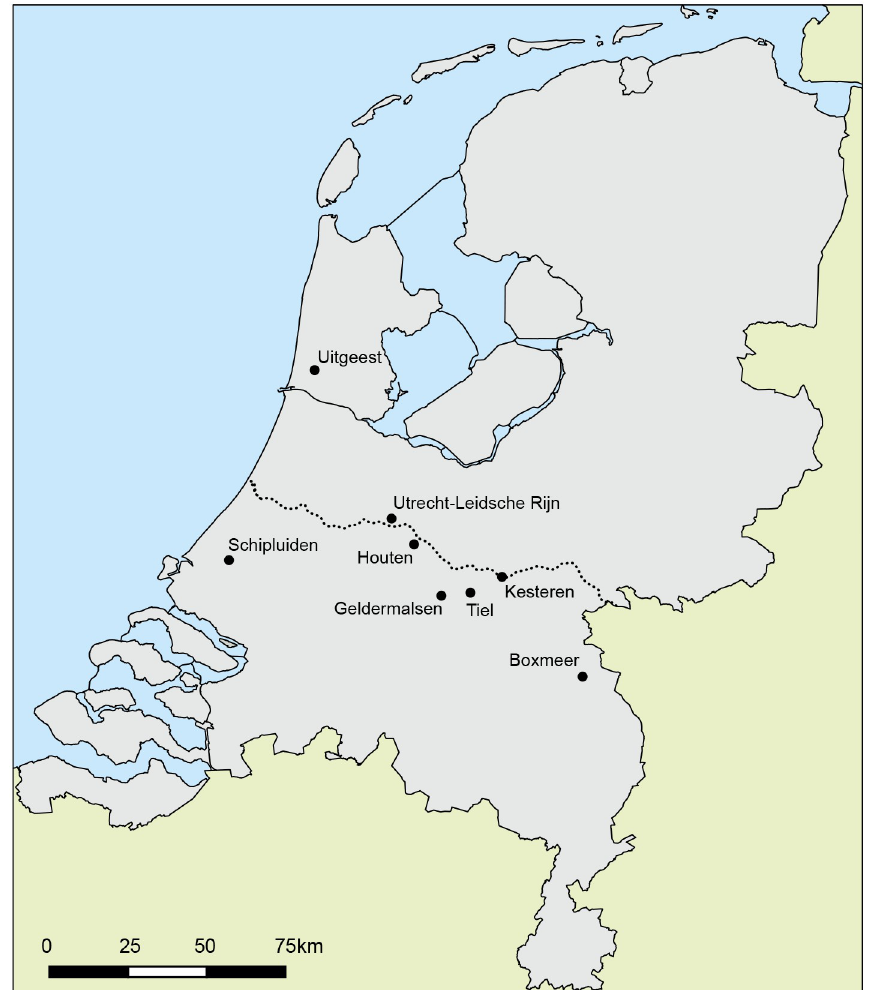
Fig 1. Map of the Netherlands. Sites mentioned in the text are marked. The dotted line represents the Roman border (Map by Marjolein Haars, BCL Archaeological Support).